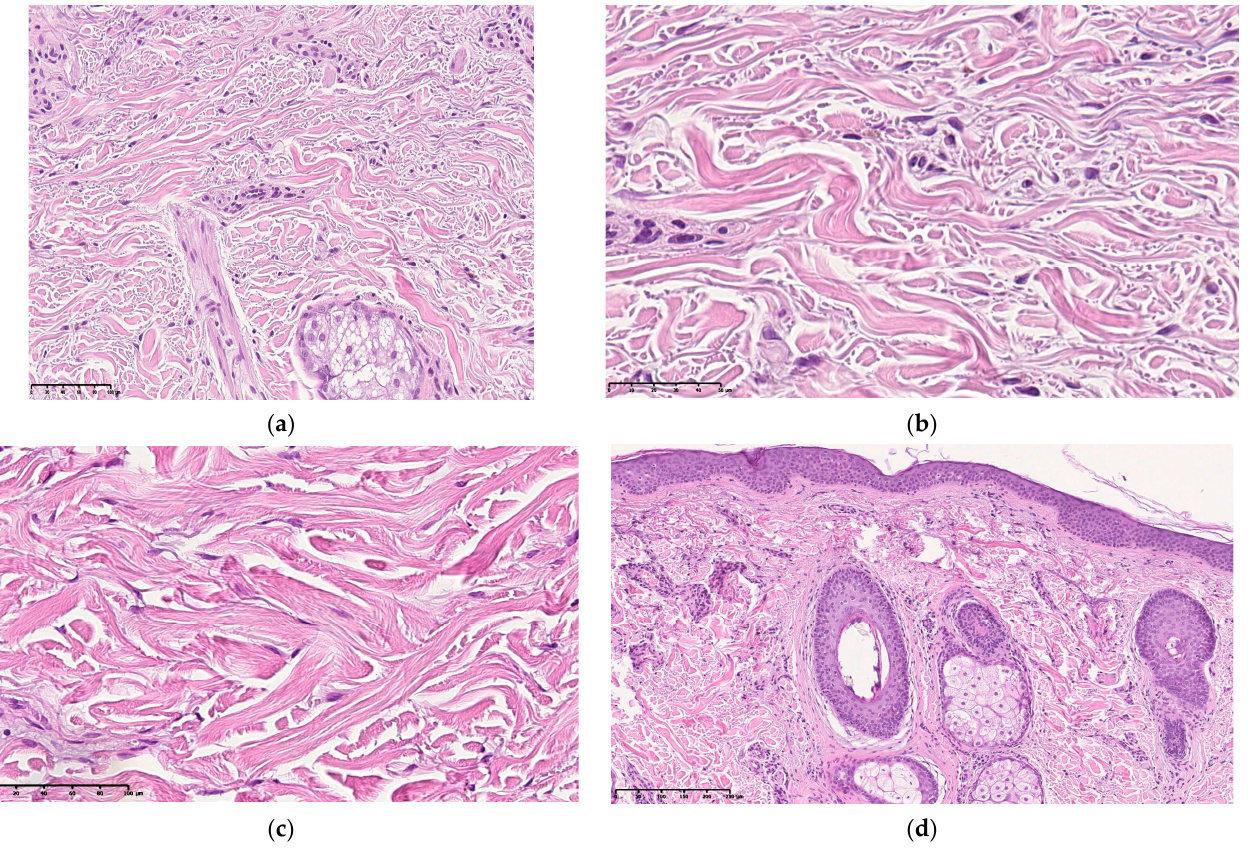
Figure 8. Micrography of the skin section after treatment: ( a ) in the main group after complex product with hyaluronic acid stained with hematoxylin and eosin, ×300; ( b ) in the main group after complex product with hyaluronic acid stained with hematoxylin and eosin, ×400; ( c ) in the main group after collagen product stained with hematoxylin and eosin, ×400; ( d ) in the main group after collagen product stained with hematoxylin and eosin, ×100.